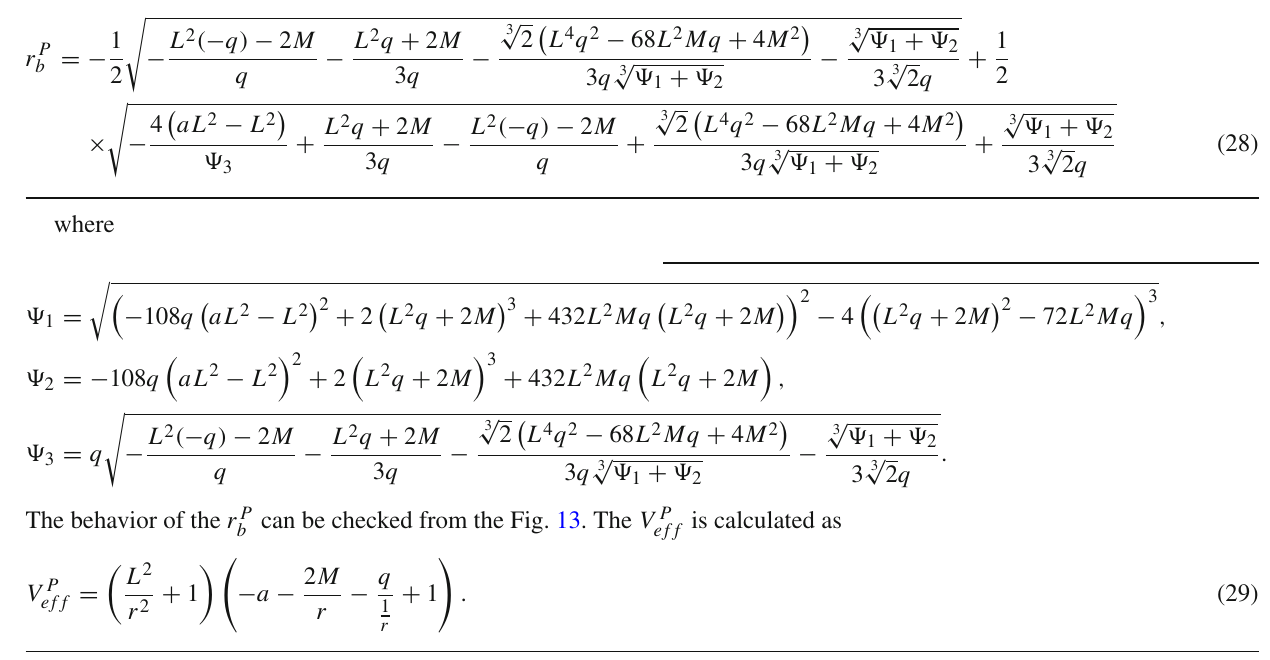
Fig. 6 Shows the behavior of V ef f ( r ) for the different possible values of a and q . The left panel of the first row represents a = 0 . 3 (blue), a = 0 . 5 (black), and a = 0 . 7 (red) with q = 0 . 01. The middle panel of the first row represents a = 0 . 3 (blue), a = 0 . 5 (black), and a = 0 . 7 (red) with q = 0 . 02. The right panel of the first row represents a = 0 . 3